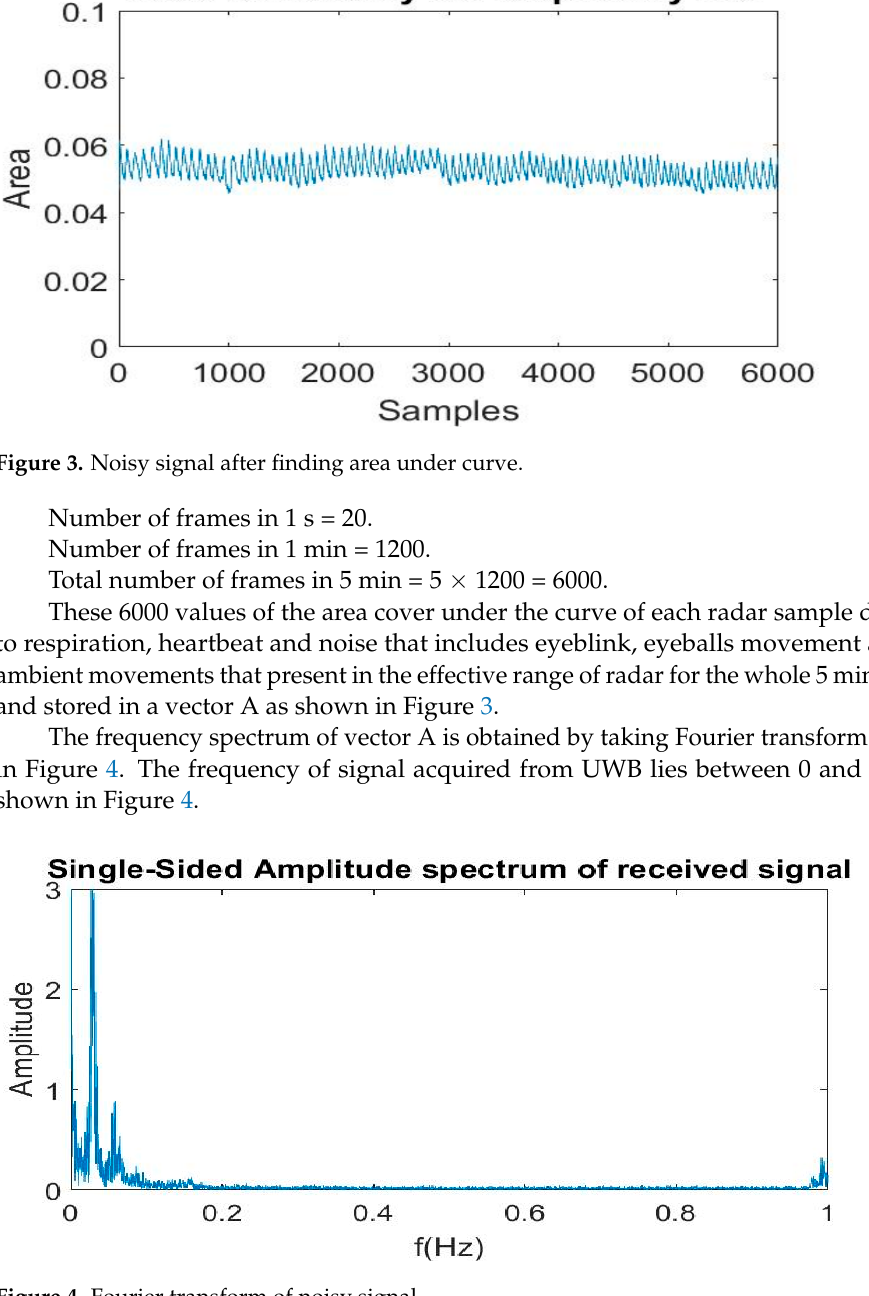
Figure 4. Fourier transform of noisy signal.